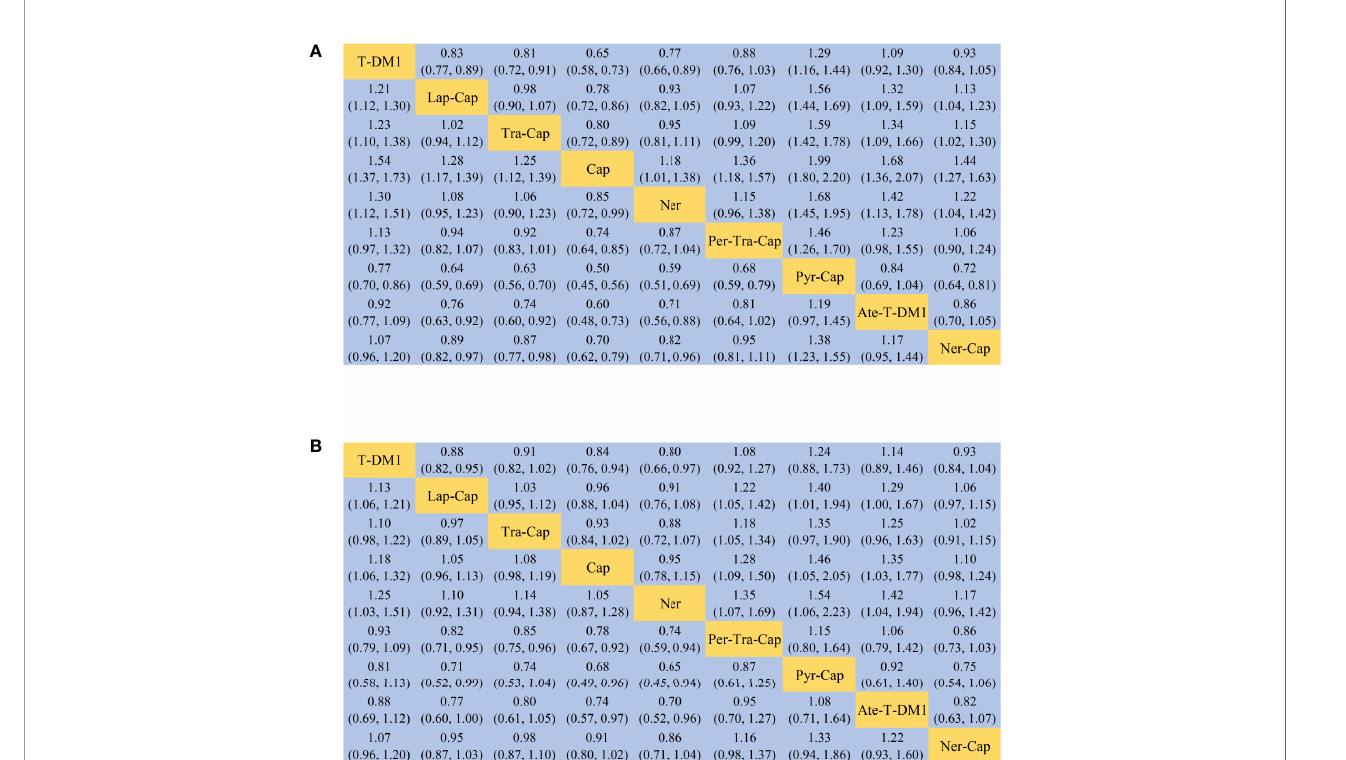
FIGURE 4 | League table of network meta-analysis of the nine anti-HER2 regimens. (A) PFS and (B) OS. PFS, progression-free survival; OS, overall survival; T-DM1, trastuzumab emtansine; Lap, lapatinib; Tra, trastuzumab; Cap, capecitabine; Ner, neratinib; Per, pertuzumab; Pyr, pyrotinib; Ate,